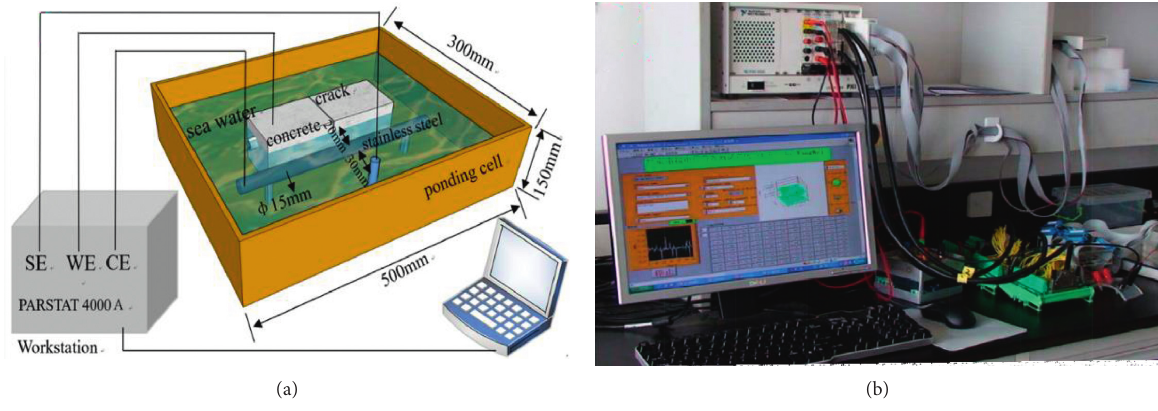
Figure 3: Test methods. (a) Electrochemical test. (b) WBE